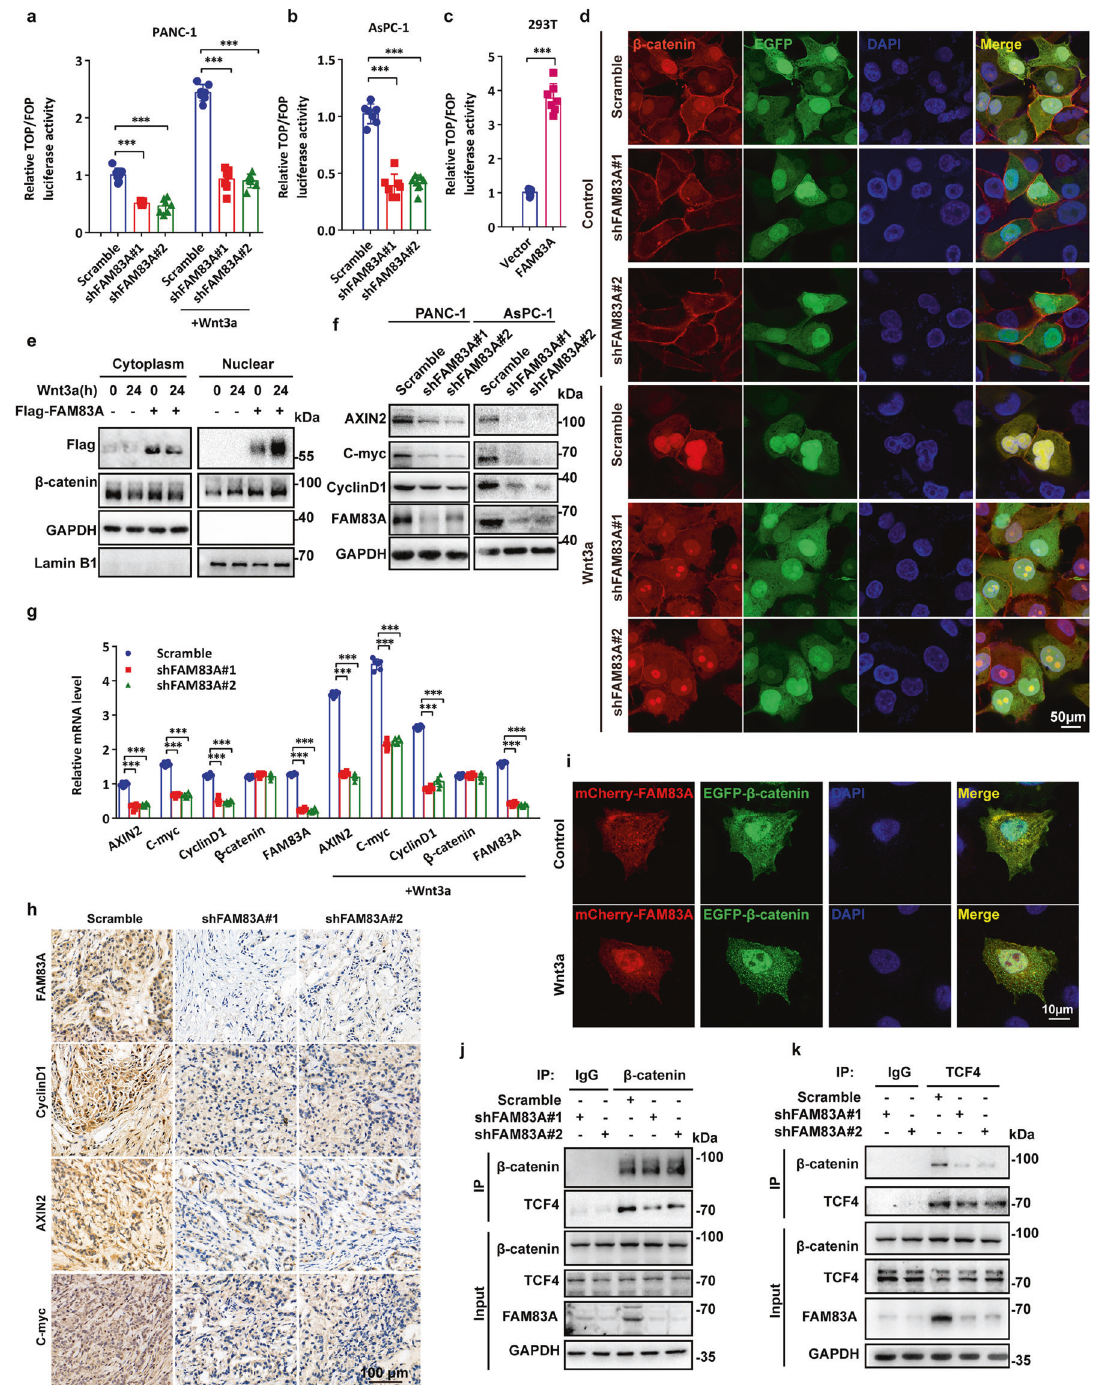
Fig. 2 FAM83A promotes canonical β -catenin transcriptional activity in human pancreatic cancer. a – c Wnt reporter luciferase activity (TOP Flash) in PANC-1, AsPC-1, and HEK293T cells with or without FAM83A knockdown or overexpression and Wnt3a treatment (100 ng/mL for 4 hours) ( n = 7). d The localization of β -catenin with or without FAM83A knockdown (cells expressing FAM83A shRNA co-expressed GFP) and Wnt3a treatment (100 ng/mL for 4 hours) were analyzed with confocal microscopy in PANC-1 cells. e The protein level of cytoplasmic and nuclear β -catenin in HEK293T cells with or without Wnt3a treatment (100 ng/mL) were analyzed with western blotting ( n = 3). f ( n = 3). g mRNA level of Wnt target genes AXIN2, C-myc, and CyclinD1 in PANC-1 cell lysates with or without FAM83A knockdown and Wnt3a treatment (100 ng/mL) ( n = 6). h Representative immunohistochemical images of FAM83A and Wnt target genes AXIN2, C-myc, and CyclinD1 expression in excised xenograft tumor tissues with or without FAM83A knockdown. i The localization of mCherry-tagged FAM83A and GFP- tagged β -catenin with or without Wnt3a treatment (100 ng/mL) in PANC-1 cells was analyzed with confocal microscopy. j , k FAM83A knockdown decreased the interaction between endogenous TCF4 and β -catenin in PANC-1 cell lysates. Protein interactions were analyzed by western blotting ( n = 3). Scale bars: 10 µm. * P < 0.05; ** P < 0.01; *** P < 0.001. Data were presented as mean ± SD